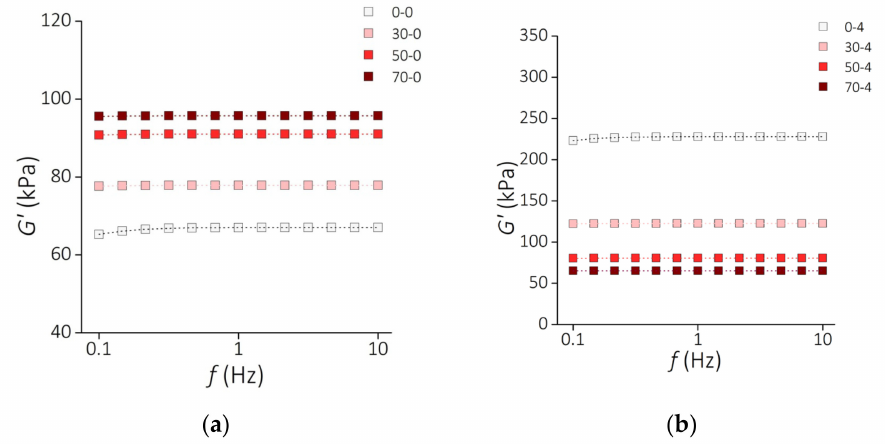
Figure 9. Rheological properties of the PDMS-MP composites. Frequency dependence of the storage modulus G (cid:48) for the samples ( a ) before incubation and ( b ) after 4 weeks of incubation. Square symbols represent the measurement points. Dashed lines show the fit to the standard linear solid